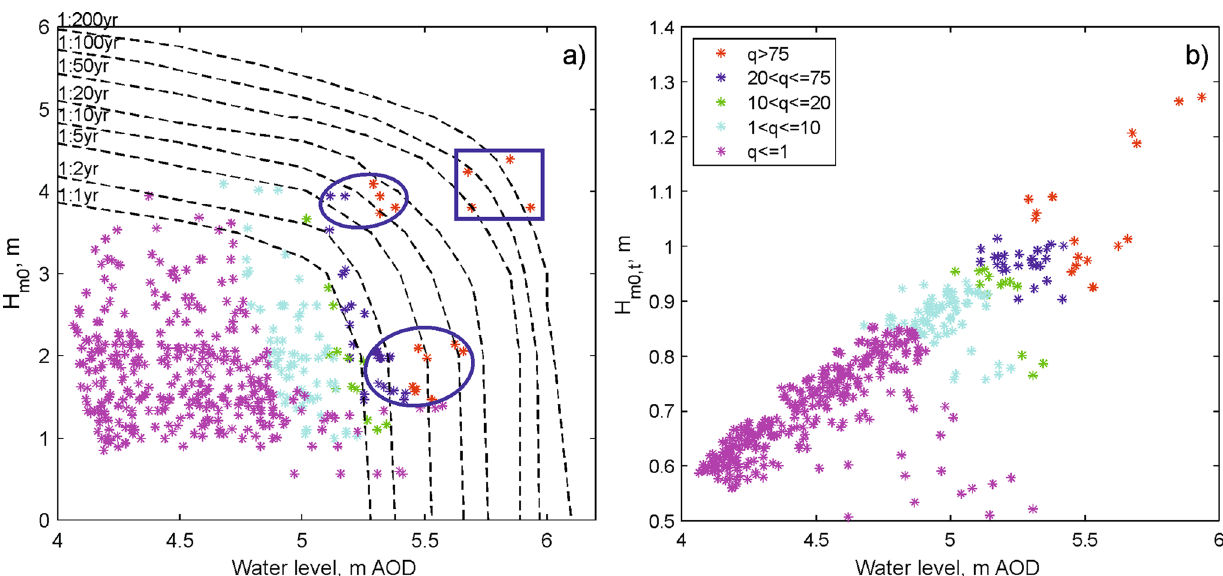
Figure 3. ( a ) The joint probability curves 20 used to identify the storm event severity at Crosby. The blue square indicates the extreme conditions that are likely to be considered for future sea wall design. Also shown are our mean overtopping discharges (q, l/s/m) for the Facebook events. The blue circles indicate overtopping events that occur relatively often (1 in 2 year) and are hazardous to pedestrians and vehicles, but are missed from the standard approach that focusses on low-probability extreme events. ( b ) Wave heights at the toe of the structure have a direct influence on overtopping (colours) and are limited by the water level (Above Ordnance Datum,